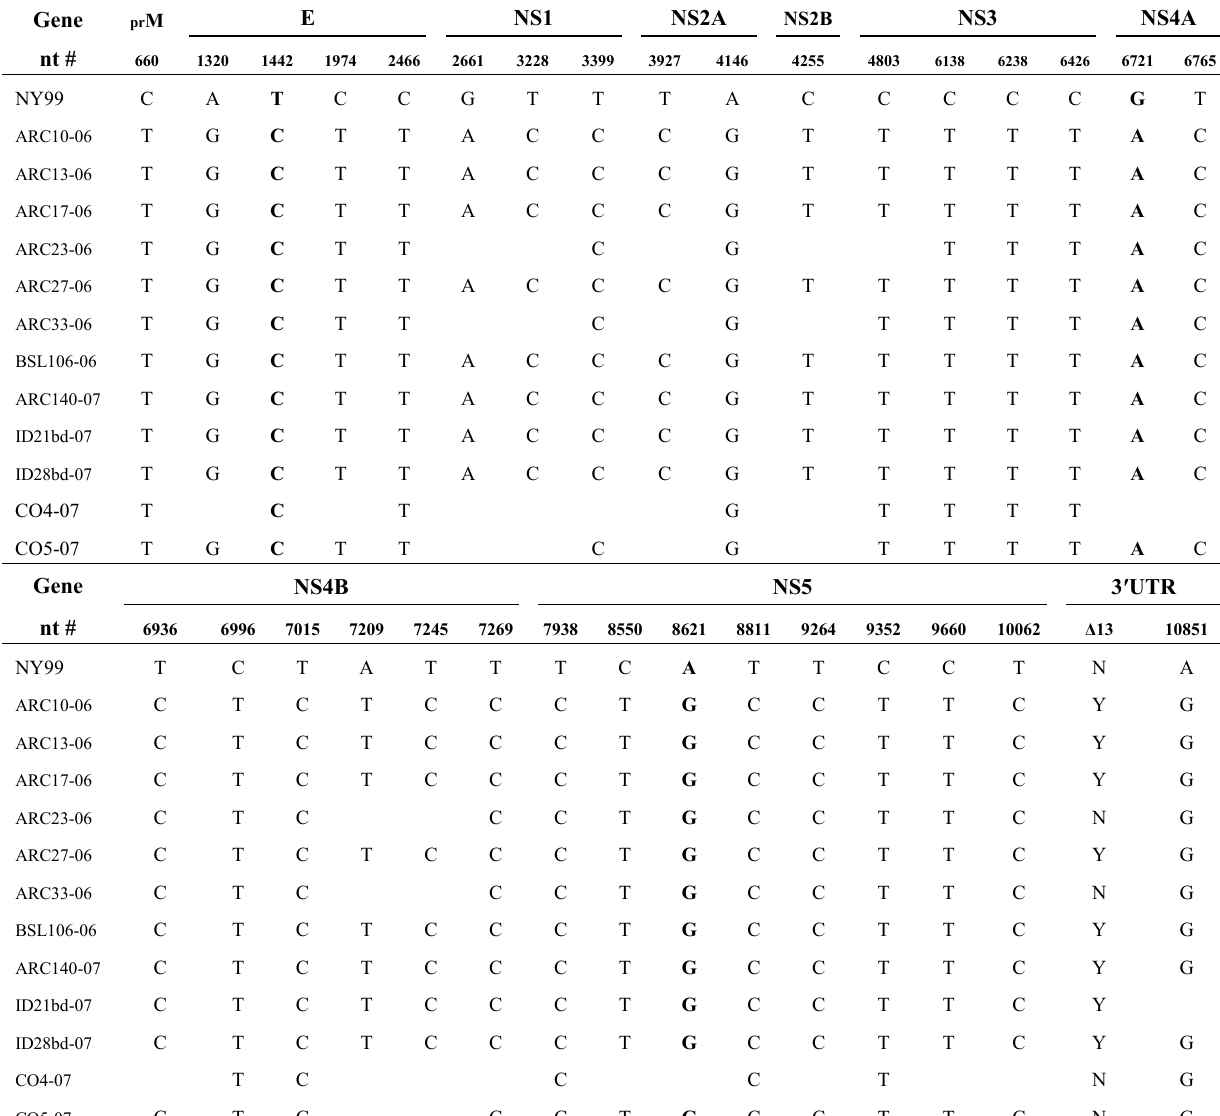
Table 2. Nucleotide mutations in studied isolates compared to the complete genome of NY99 (AF196835). Non-silent mutations are shown in bold and resulted in amino acid substitutions E-V A, NS4A-A T and NS5-K 159 85 314